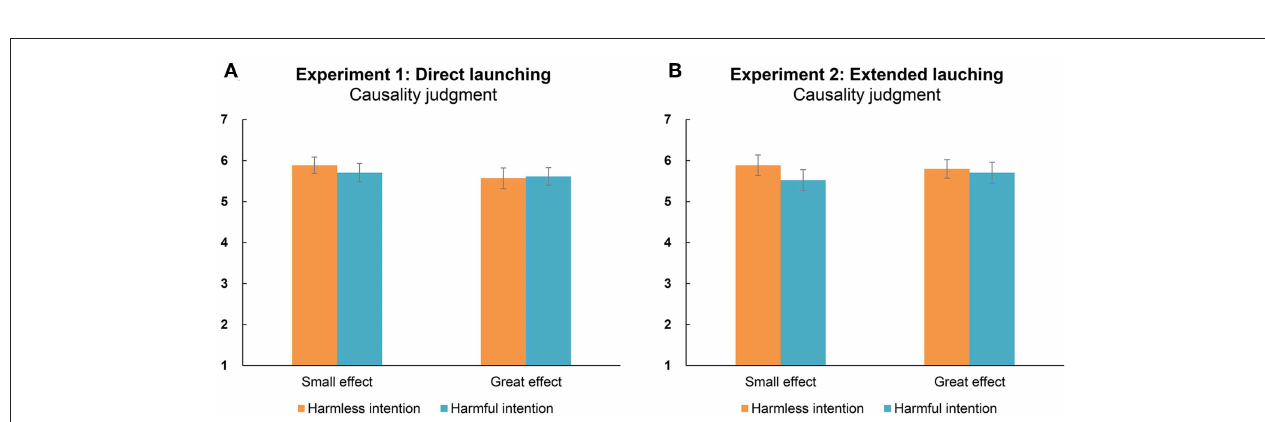
FIGURE 1 | Judgment of the actor’s intent (i.e., purple hexagon) affecting the recipient (i.e., yellow square) under different acting conditions in Experiment 1 (A) and Experiment 2 (B) . A score of 1 means “completely disagree” and 7 means “completely agree.” Error bars indicate the standard errors ( ± SE).